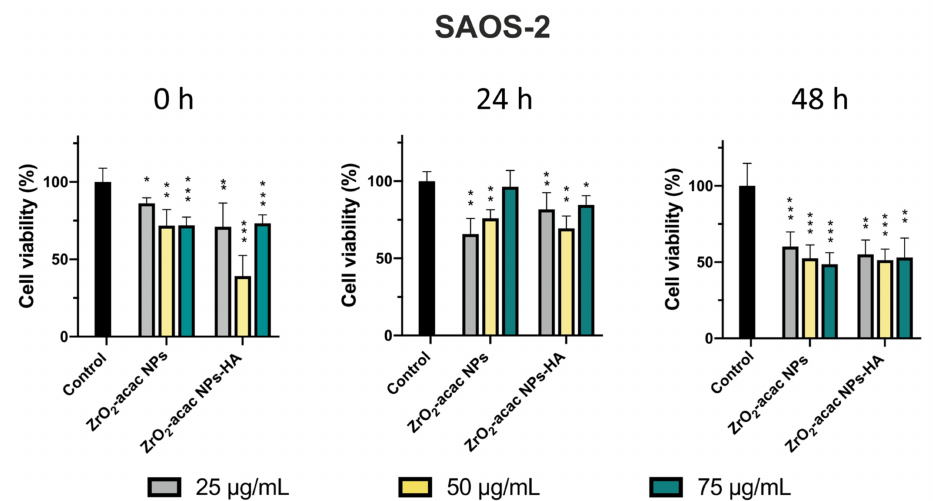
Figure 5. Cytotoxicity test performed with the Alamar Blue assay after 24, 48, and 72 h of incubation of SAOS-2 cells with ZrO 2 -acac NPs and ZrO 2 -acac NPs-HA at 25 (grey), 50 (yellow), and 75 (green) µ g mL − 1 . The level of significance was set at probabilities of * p < 0.05, ** p < 0.01, and *** p < 0.001. The results are expressed as the mean ± s.d. ( n ≥ 3). Non-significant data are not